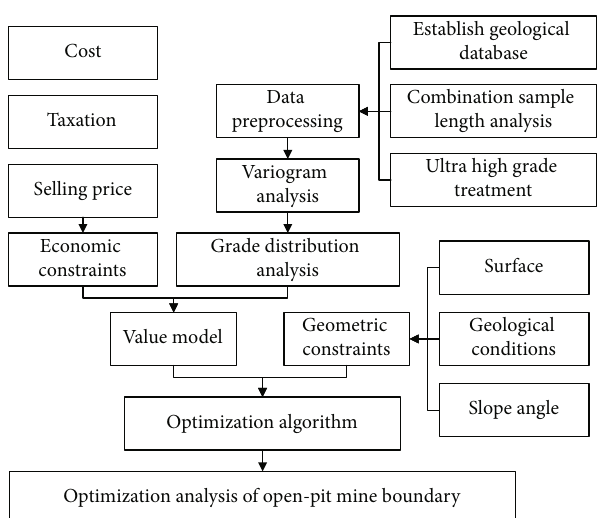
Figure 9: Excavation stage three.